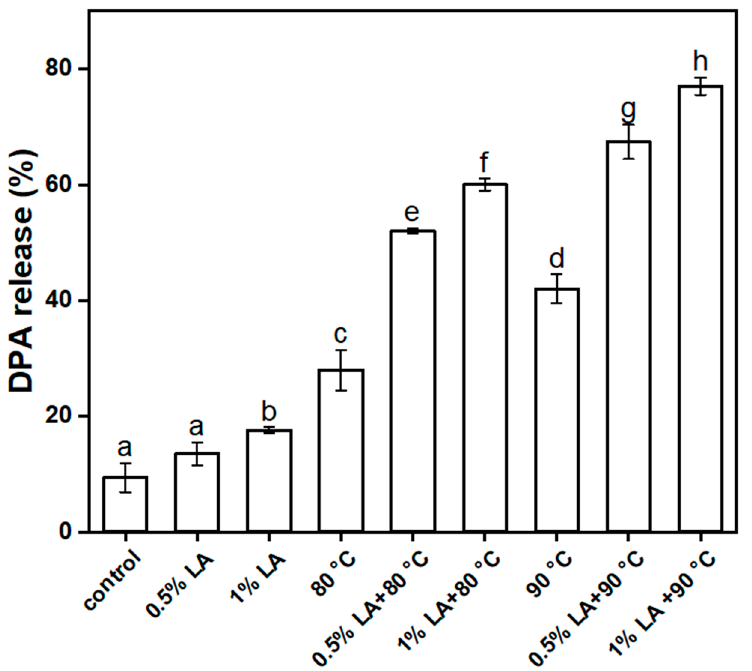
Figure 4. Plot of the changes in DPA release rate after different treatments for 30 min. Different lowercase letters indicate significant differences between treatments ( p < 0.05).